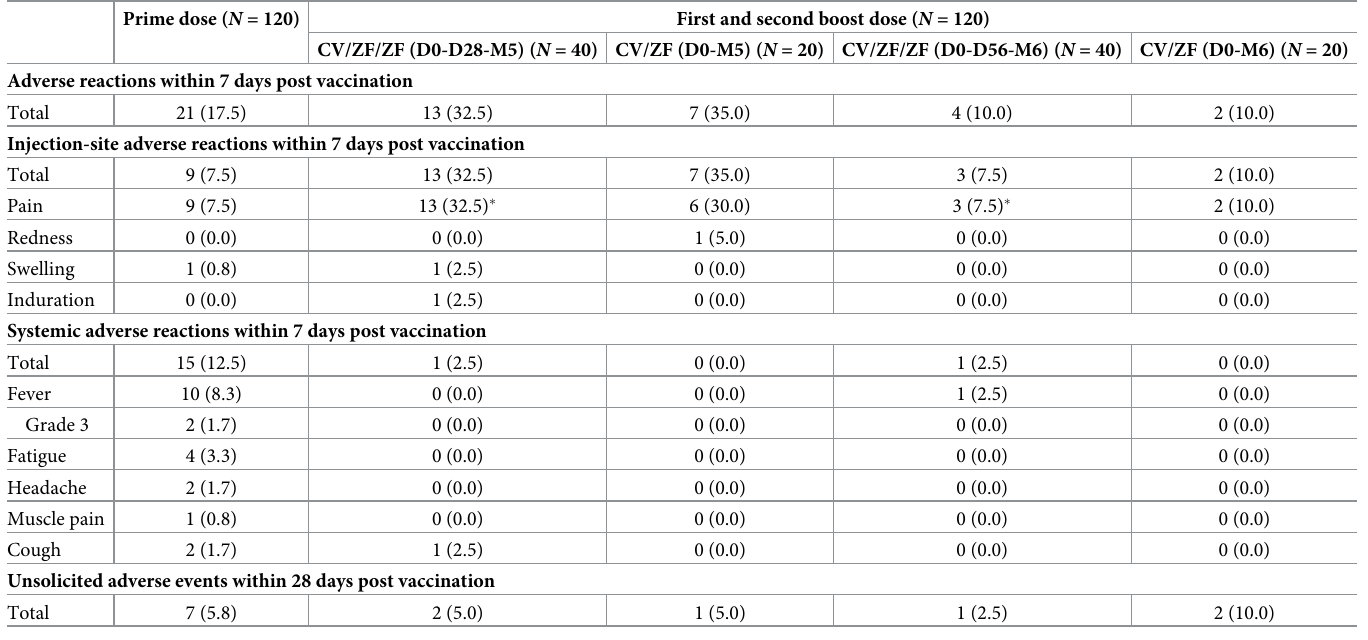
Table 2. Adverse reactions occurred within 7 days and unsolicited adverse events within 28 days post vaccination. Prime dose ( N =